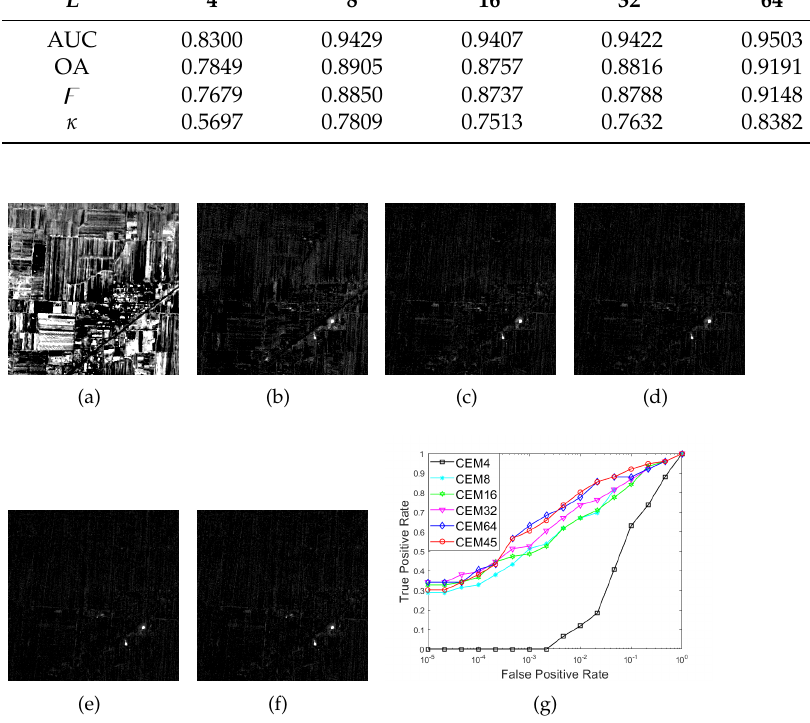
Figure 5. For the Xi’an data with 64 bands, ( a – e ) the CEM results for different numbers of bands, where L = 4,8,16,32,64; ( f ) the CEM result with the skewness selection process, and L = 45; ( g ): the ROC curves for the CEM results with different L